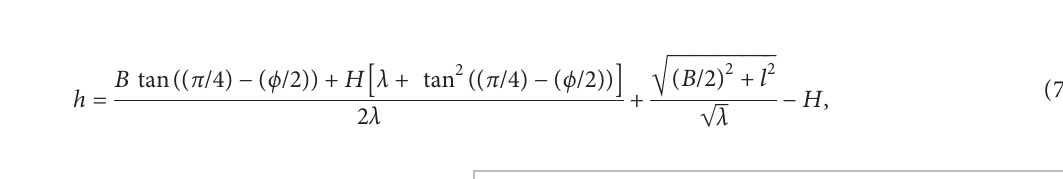
Figure 1: Geometric form of composite rock-bolt bearing structure: (a) arch; (b)